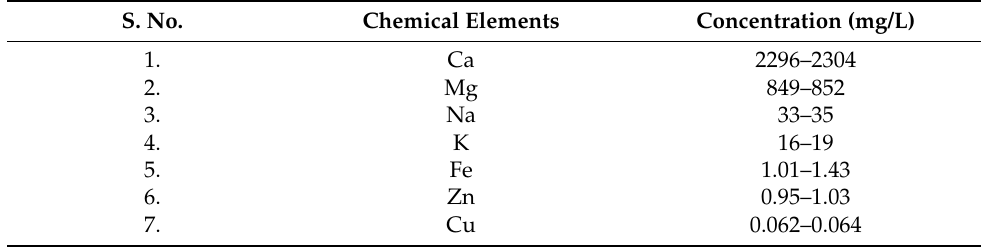
Table 4. The chemical composition of chicken